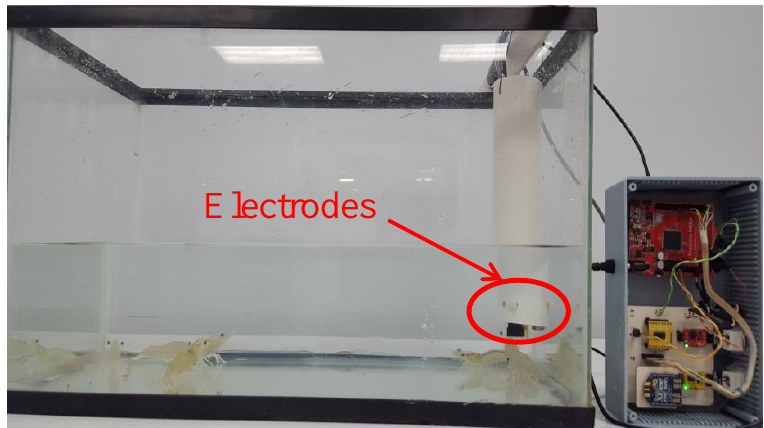
Figure 2. Experimental setup with 7 g five shrimp in 20 L of marine water and the proposed electronic system (gray box).